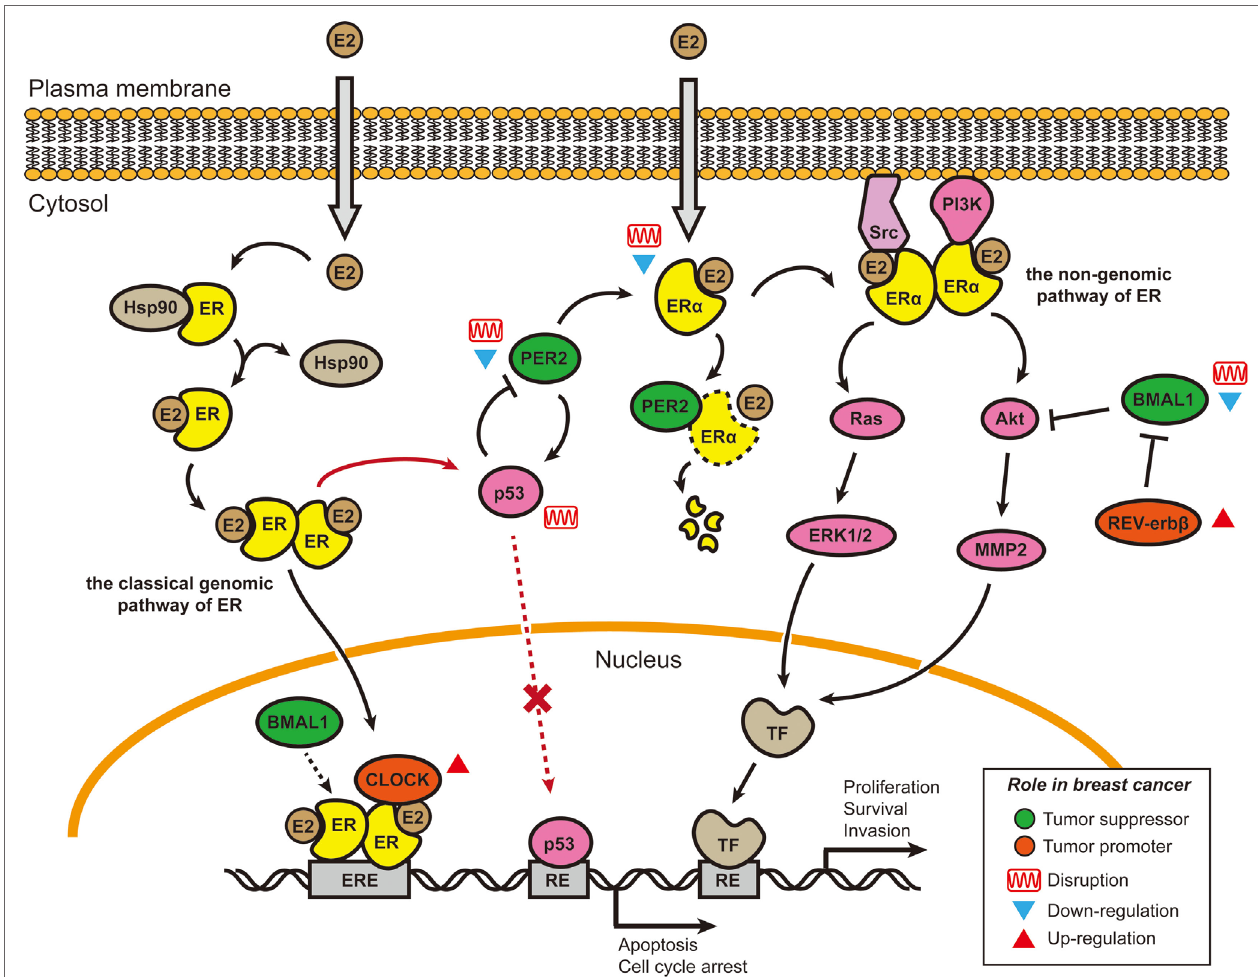
FiGURe 1 | Cross talk between E2–estrogen receptor- α (ER α ) signaling pathways and circadian rhythms in breast cancer. Two of the four estrogen signaling pathways involve E2 stimulation and are shown here (65). In the classical genomic pathway, E2-bound estrogen receptor (ER) (either ER α or ER β ) dimerizes, changes conformation, translocates to the nucleus, and binds to the estrogen response elements (EREs). After binding to the EREs, the E2–ER complex recruits other co-activators, including Circadian Locomotor Output Cycles Kaput (CLOCK) and possibly brain and muscle Arnt-like protein 1 (BMAL1) (74), to initiate the transcription of target genes. CLOCK overexpression in breast tumors and promotion of tumor cell proliferation may be caused by co-activation with E2–ER complexes (77, 78). In the non-genomic pathway, E2–ER α complexes accumulate near the membrane and then recruit protein kinases [Src and phosphoinositide 3-kinase (PI3K)] to activate signaling cascades (Akt and Ras/MAPK). BMAL1 has been shown to suppress the Akt/MMP2 pathway and further inhibit cancer cell invasion (79). BMAL1 can suppress cancers, and its expression is downregulated or disrupted in various breast cancer cell lines (67, 80–83). By contrast, REV-ERB β (a repressor in the secondary transcriptional/translational feedback loop) is generally overexpressed in breast tumor samples; its protective function can allow cancer cells to develop chemotherapy resistance (84). PER2 is a direct ER α target gene and can bind to ER α and cause its degradation. In ER α -positive breast cancer cells, both PER2 and ER α lose their circadian oscillations, the underlying mechanism of which is not well understood. The cancer suppressor p53 can directly bind to the PER2 promoter and inhibit its transcriptional activity (85). E2–ER complexes can block the induction of proapoptotic p53 target genes by binding to p53 protein in ER-positive breast cancer cells, thus helping cancer cells avoid apoptosis (73). Re-introduction of PER2 into the ER-positive breast cancer cells can induce p53 expression (72). Abbreviations: TF, transcriptional factor; RE, response element; E2, 17 β